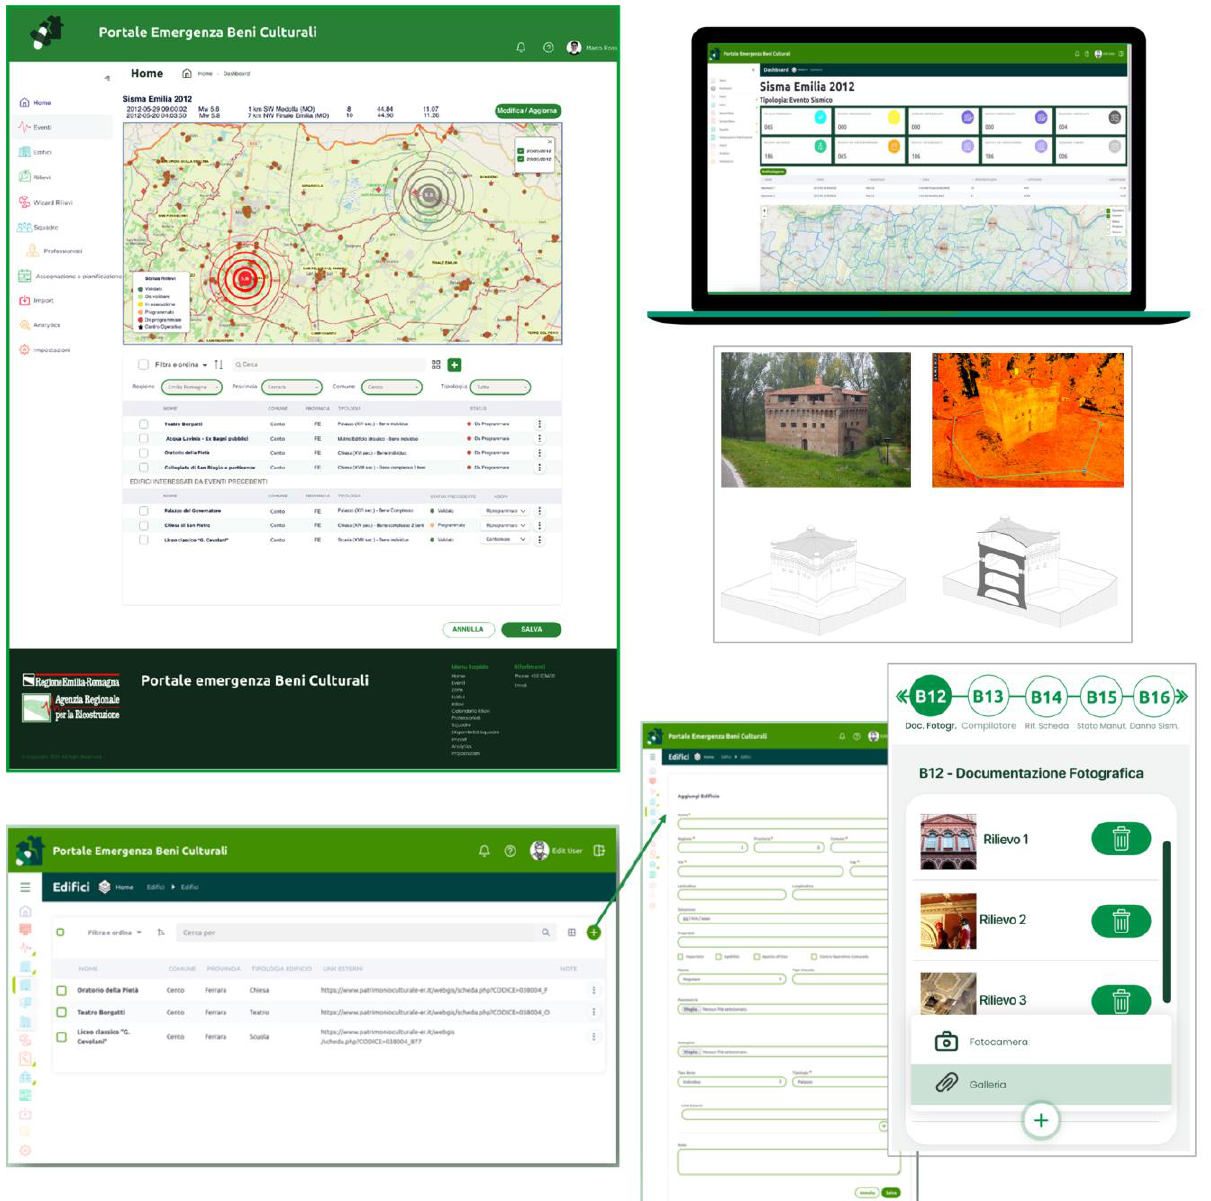
Figure 4. Integrated digital platform for damage assessment and risk